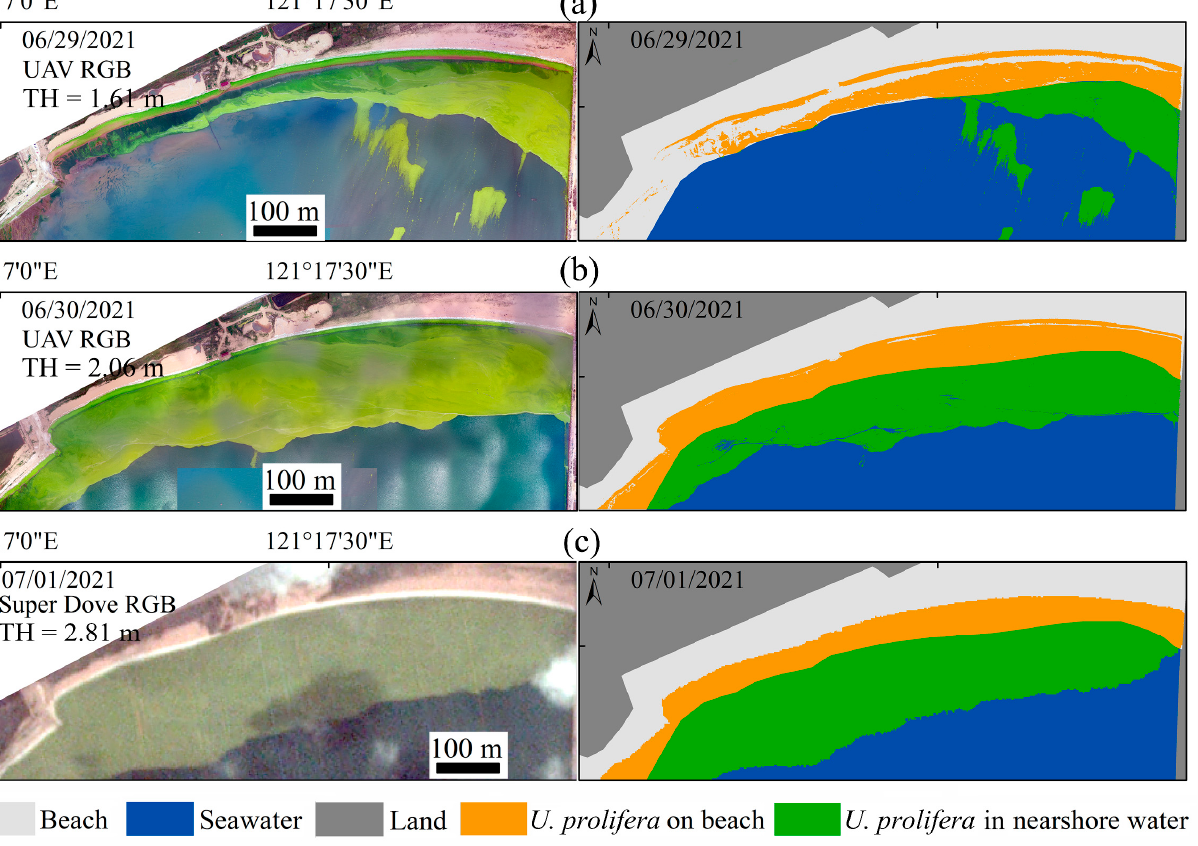
Figure 10. The extraction results of U. prolifera on the beach and in nearshore water in the P3 area. ( a ) The extraction results of U. prolifera from a UAV image on 29 June 2021; ( b ) The extraction results of U. prolifera from a UAV image on 30 June 2021; ( c ) The extraction results of U. prolifera from a Super Dove image on 1 July 2021. The local tide height (TH) at the time of each image acquisition is marked on the figure.